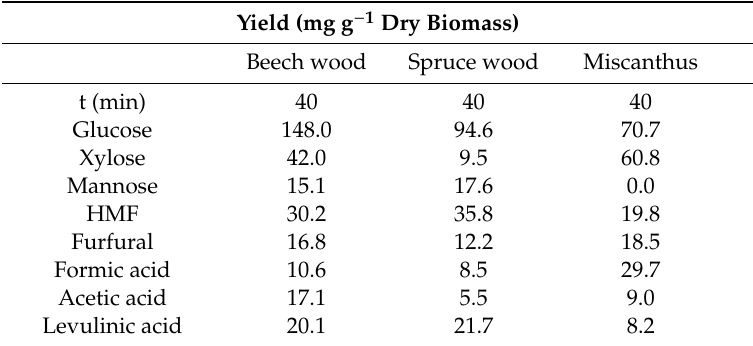
Table 3. Main components yield after 40 min hydrolysis of di ff erent biomass with 0.05 mol L − 1 sulphuric acid at 200 ◦